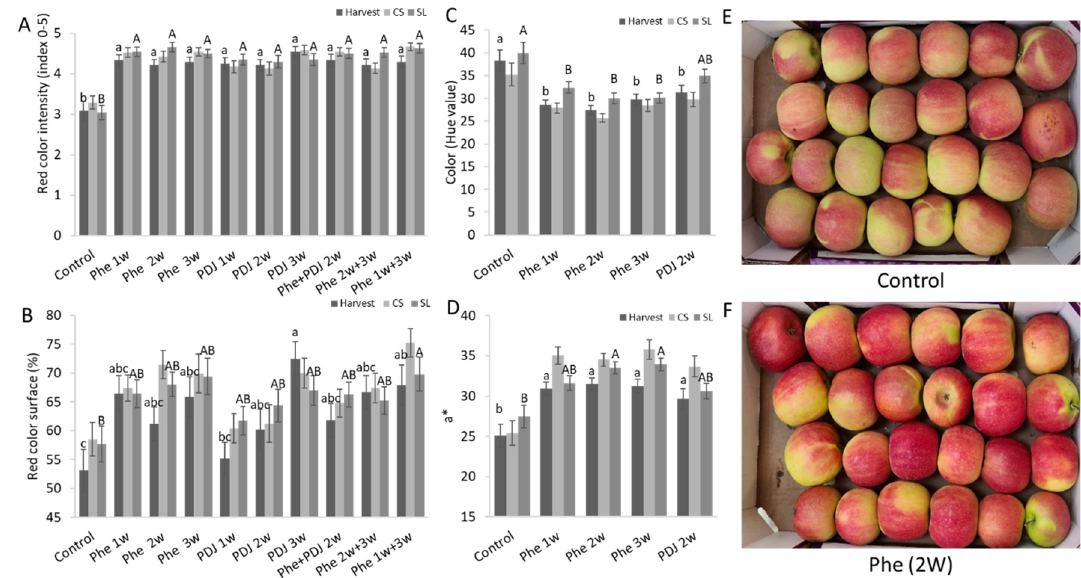
was evaluated at harvest (T0), after cold storage (CS, 3 weeks at 12 °C), and after shelf life (SL, 7 days at 22 °C). ( A ) Red color intensity (index 0 − 5). ( B ) Red surface area (% of fruit coverage). ( C ) Color (Hue value of the reddest point). ( D ) Green-red color range (a* value). ( E ) Representative pictures of ‘Kent’ mango boxes after shelf-life storage. Mean values and standard errors are presented. Statistical analysis was conducted for each time point separately (small or capital letters). Different letters represent a significant difference ( p ≤ 0.05).